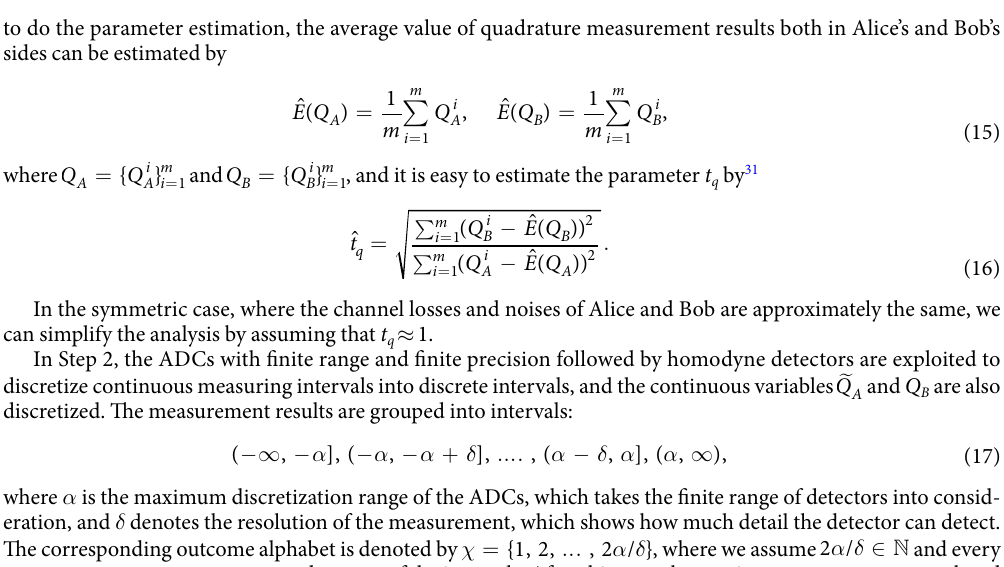
is used for generating Bob’s data and the reflection B and | | p are t 1 t 2